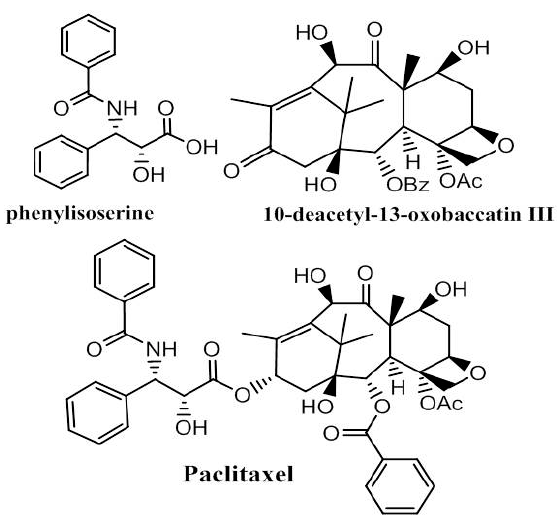
Figure 2. Paclitaxel obtained by a coupling reaction between (2 R ,3 S )- N -benzoyl-3-phenylisoserine and the baccatin III core structure.